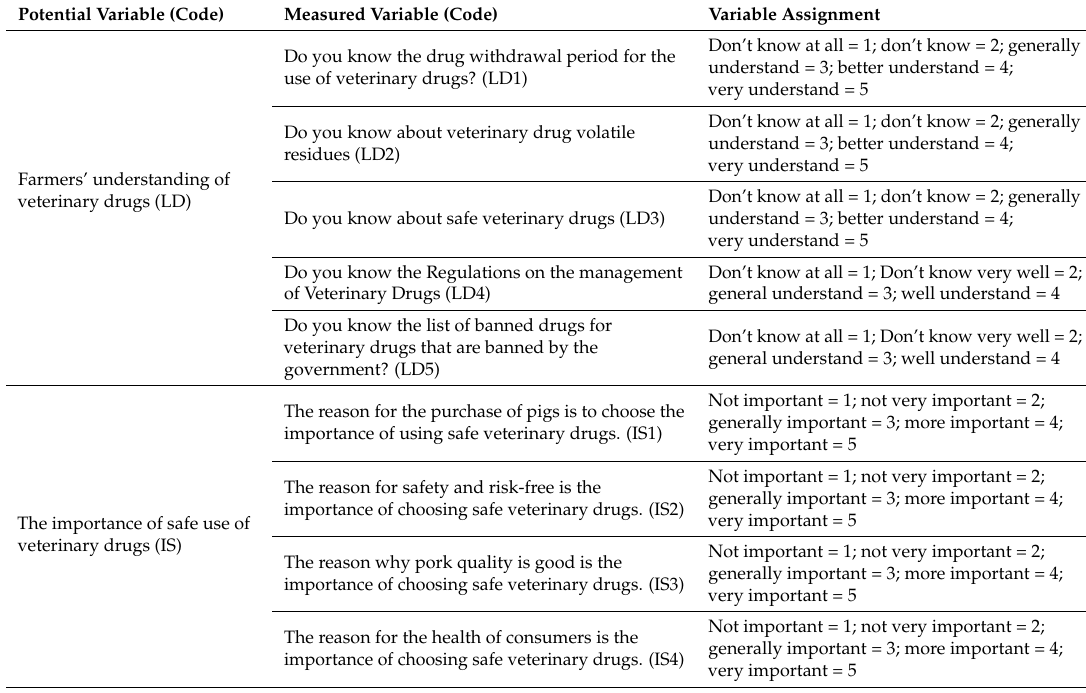
Figure 2. Path diagram of SEM (Structural Equation Modeling). Table 3. Structural equation variables affecting the behavior of farmers’ veterinary